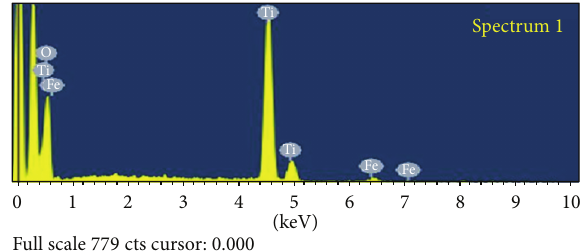
Figure 2: EDAX spectra of 4% manganese doped TiO 2 .